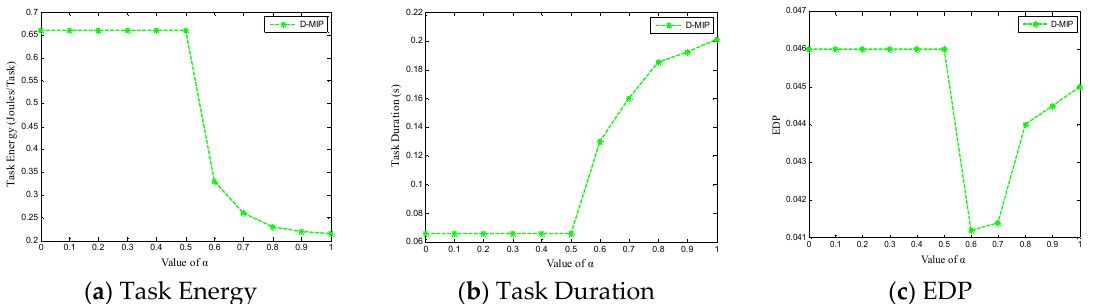
Figure 11. Corresponding Relationship between Energy Consumption, Task Delay, EDP and Control Parameter α .